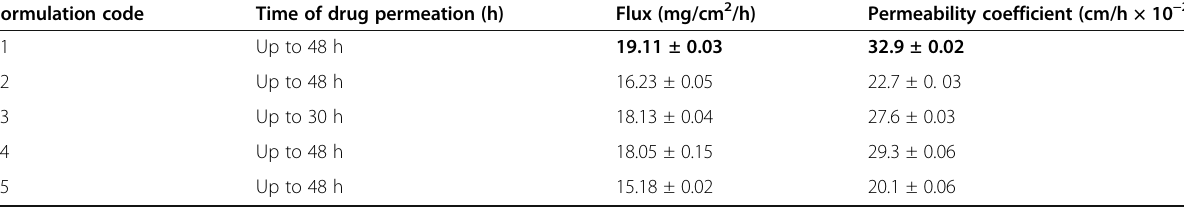
Table 2 In vitro permeation parameters of CV from single-layer drug-in-adhesive formulations (mean ± SD, n = 3) Formulation